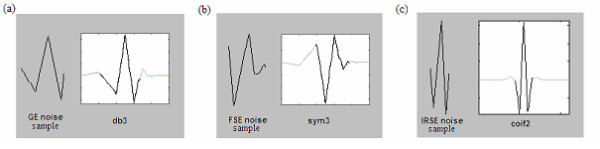
Example of comparison between noise shapes and some wavelets. FSE, GE and IRSE sequences, which resemble the db3, sym3 and coif2 wavelets respectively.